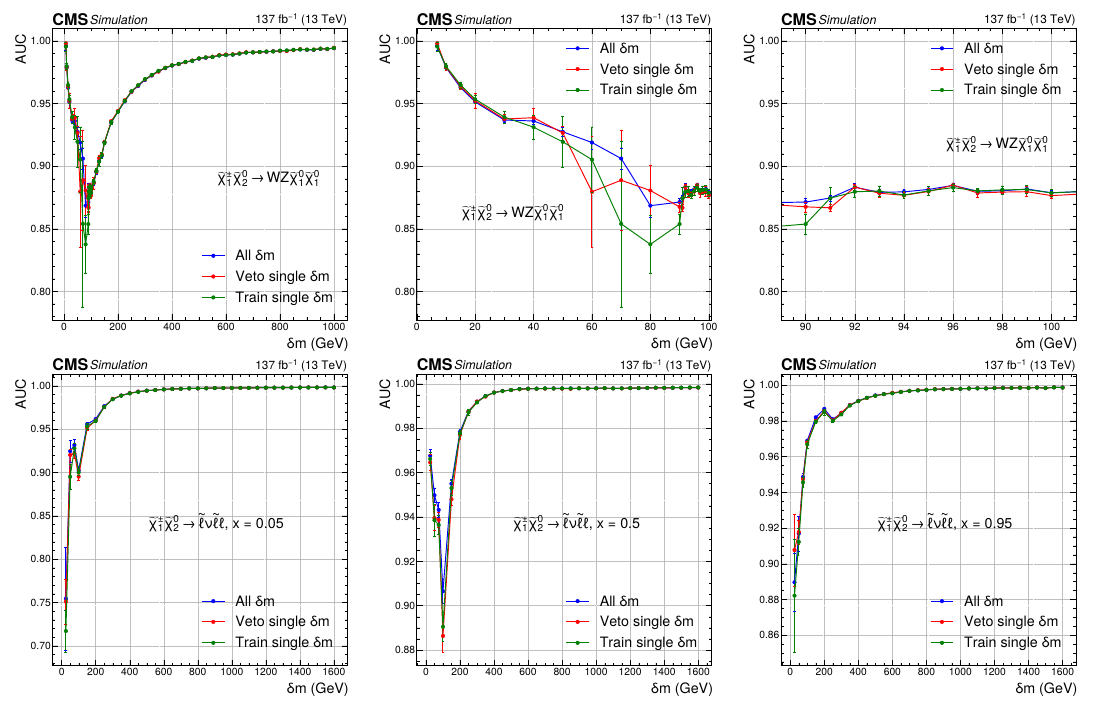
Figure 4 . The AUC performance of the parametric neural networks for discriminating the signal from the total background predicted in simulation, as a function of δm for the trainings targeting different signal models. The top row corresponds to the neutral network targeting signals with WZ -mediated decays with different mass ranges to show all points. The bottom row corresponds to the models with slepton-mediated decays at x = 0 . 05 (left), x = 0 . 5 (middle) and x = 0 . 95 (right). Neural network models shown in blue are trained using all available δm points, those in red are trained with all available points except the point for which the performance is shown. The models in green are not parametric and only trained to find a signal at the point where the performance is indicated. Each neural network is retrained ten times, and the mean performances are shown, with error bars indicating the standard deviation computed from ten performance values. This means that each red and green point correspond to ten neural network trainings. The entire blue curve in each figure also corresponds to ten